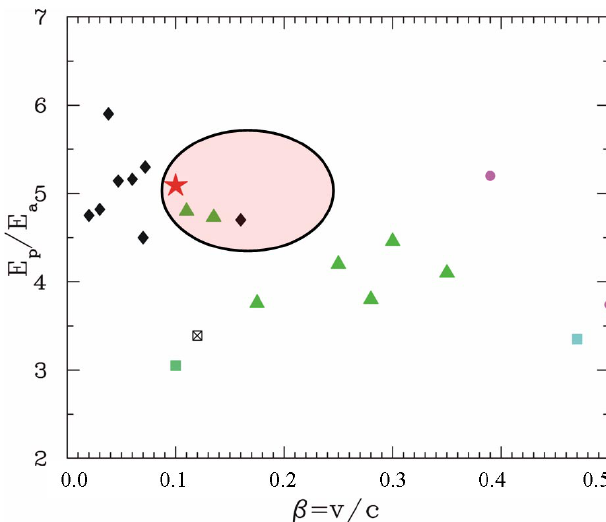
=E of the electric peak field and p a